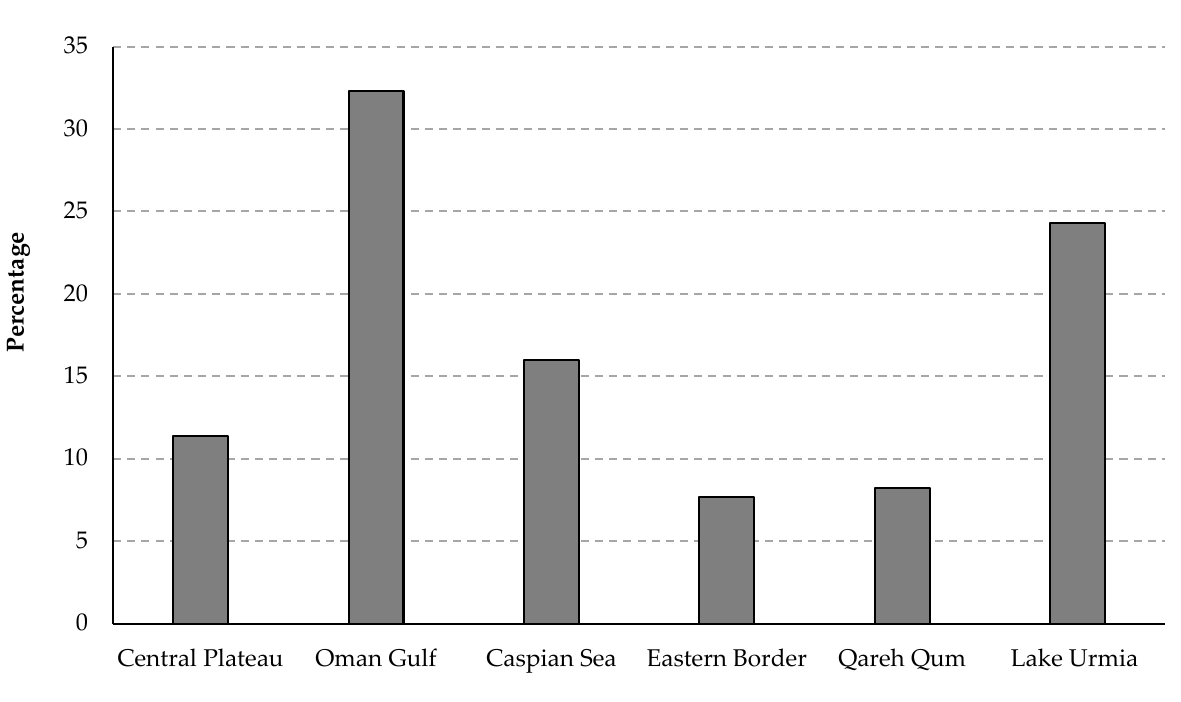
Figure 3. Average air temperature in Iran (1990–2021).